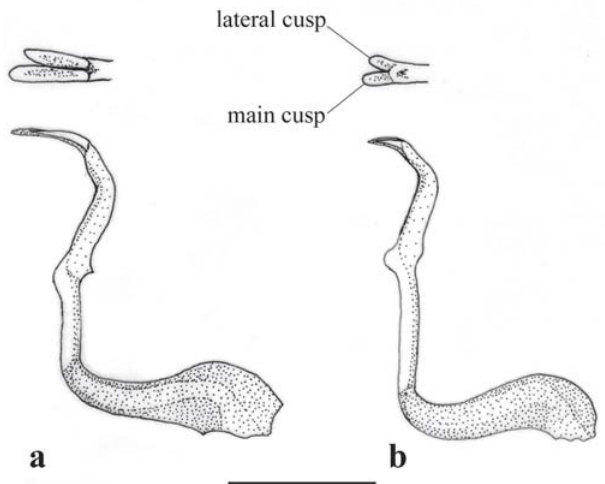
Fig. 3. Lateral view, distal portion to top, of left premaxillary tooth of Lamontichthys avacanoeiro (MZUSP 61974, 113.7 mm SL, paratype) (a), and L . filamentosus (LACM 41741-9, 119.4 mm SL) (b). Detail of cusps in anterior view, distal tip to left. Scale bar = 0.5 mm.